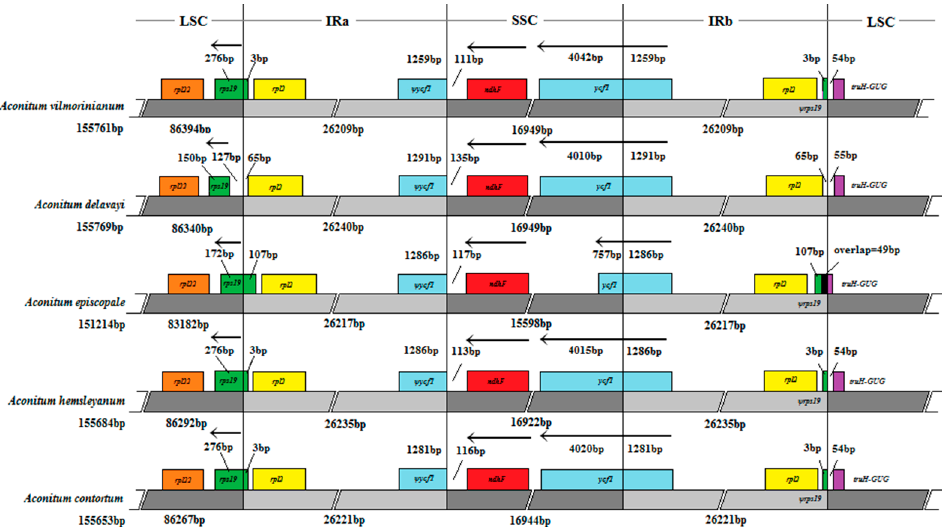
Figure 7. Comparisons of LSC, SSC and IR region borders among five Aconitum chloroplast genomes. ψ indicates a pseudogene. Genes are denoted by colored boxes. The number above the gene features shows the distance between the end of the gene and the borders sites. The slashes indicate the location of the distance. The arrows indicated the orientation (5’ → 3’) of the rps19 , ndhF and ycf1 genes. This figure is not to scale.